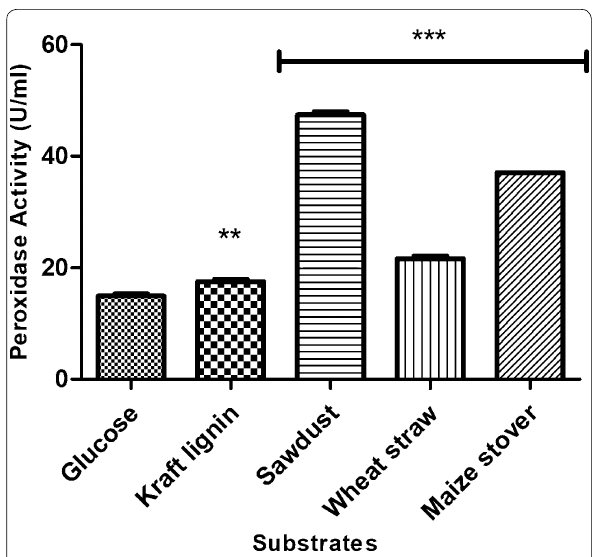
Fig. 7 Exploitation of agroresidues for improved peroxidase activity expression by BMAB-1. Each column signifies mean difference is ***highly significant ( p < 0.05) when compared with glucose and kraft lignin and **significant ( p < 0.05) when compared with